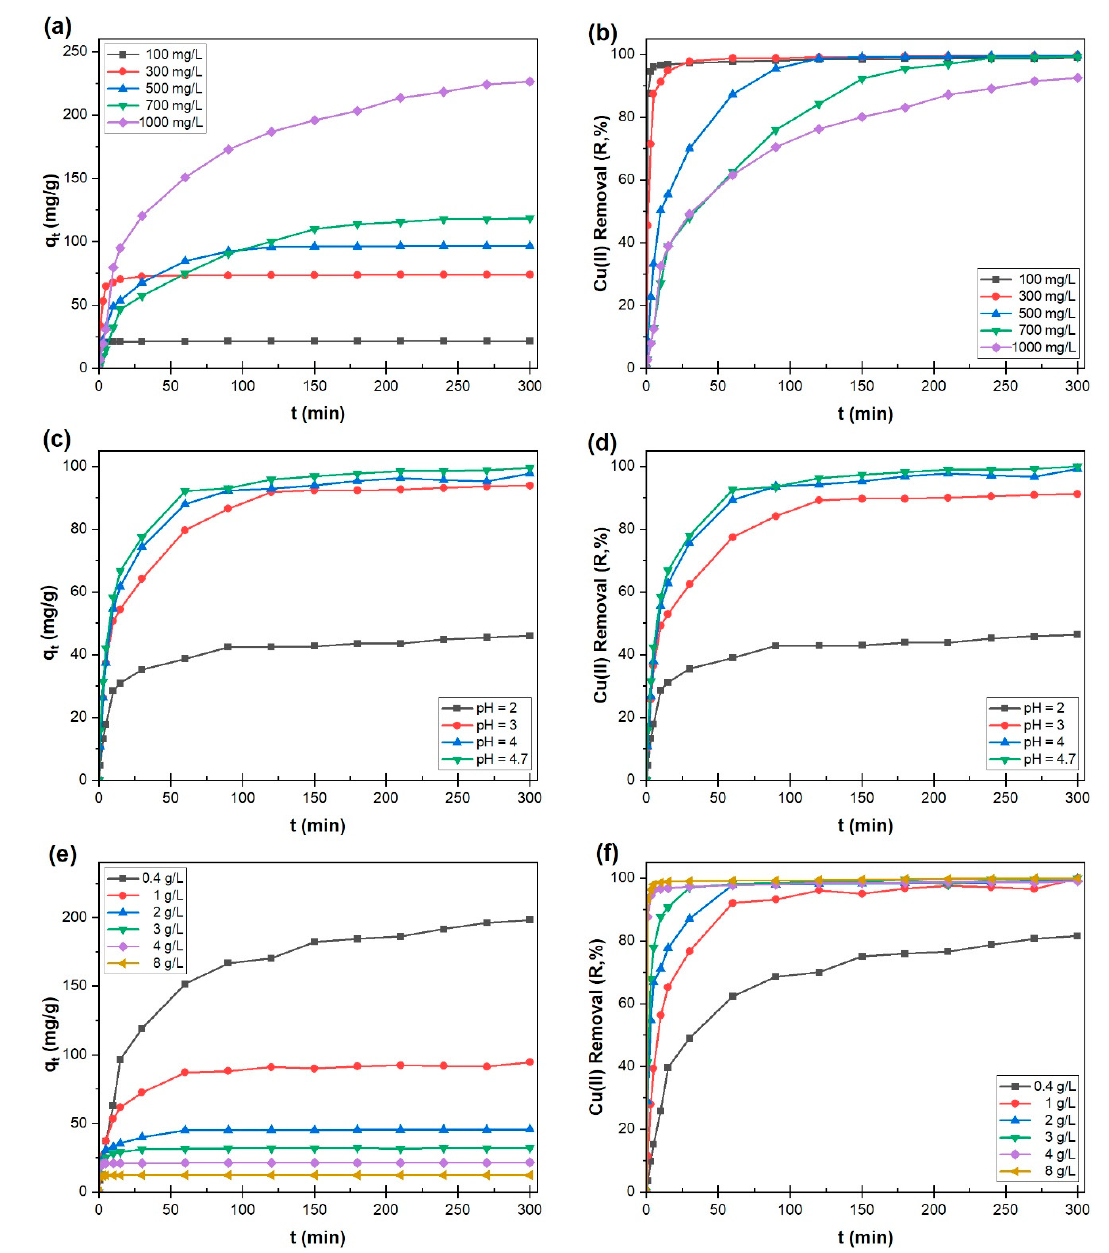
Figure 2. q t values and copper removal (R%) to investigate the effect of ( a , b ) Cu concentration; ( c , d ) pH; ( e , f ) adsorbent amount. ( c , d ) pH; ( e , f ) adsorbent